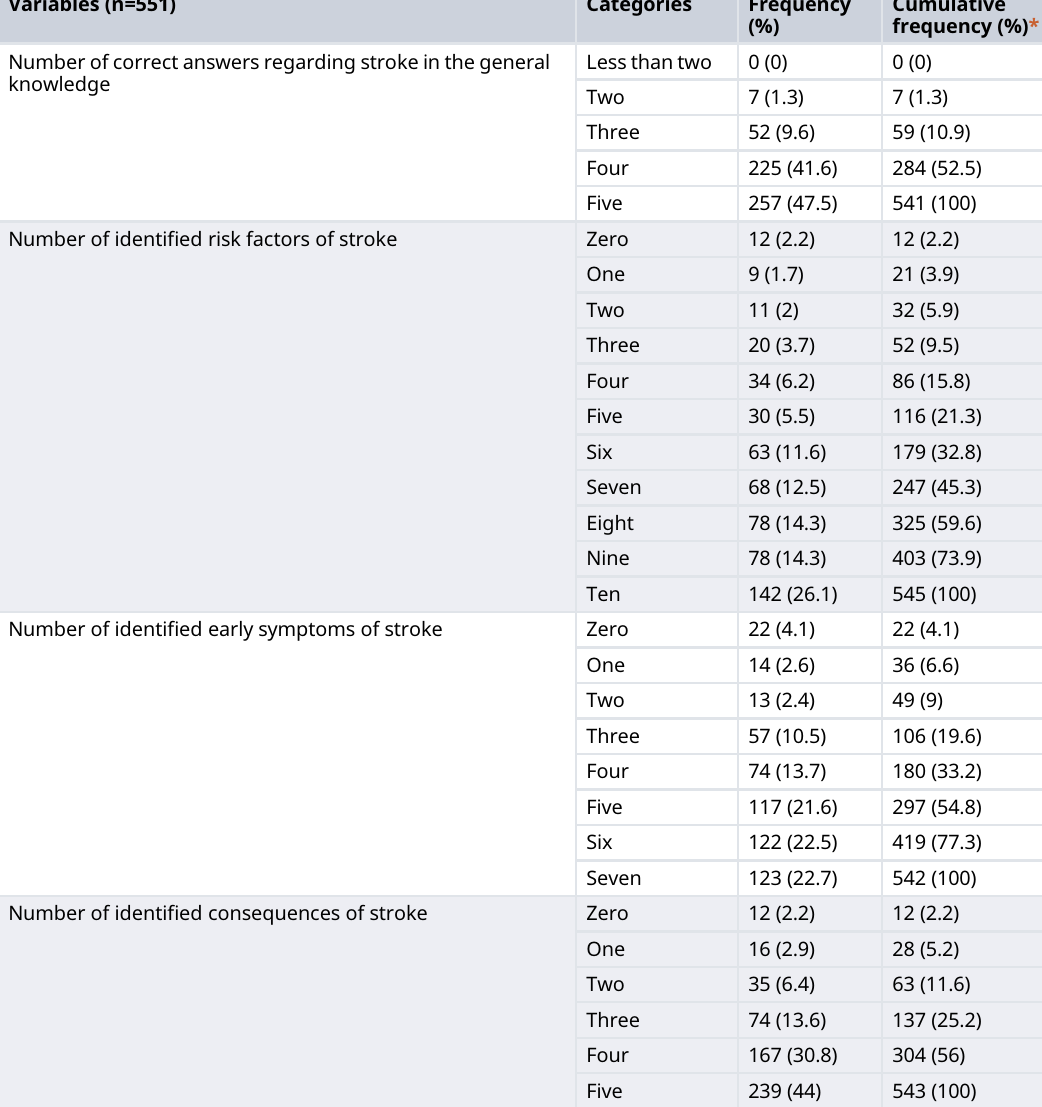
Table 2. Number of stroke risk factors, early symptoms, and consequences that were identified by the participants. Variables